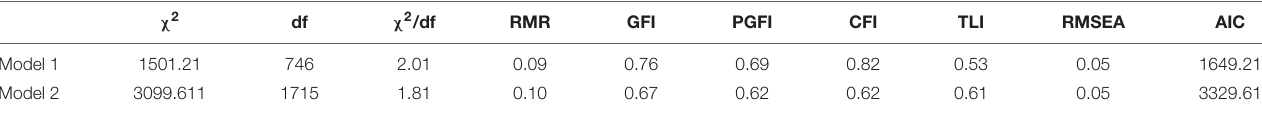
FIGURE 3 | The model 2. TABLE 5 | Comparative summary of model